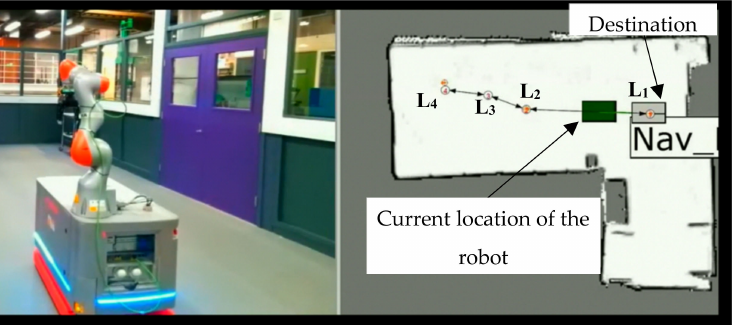
Figure 10. Live location of the robot updated on the map as the robot moves towards the storage area. L 1 to L 4 are the storage area, home point, path waypoint, and materials transfer